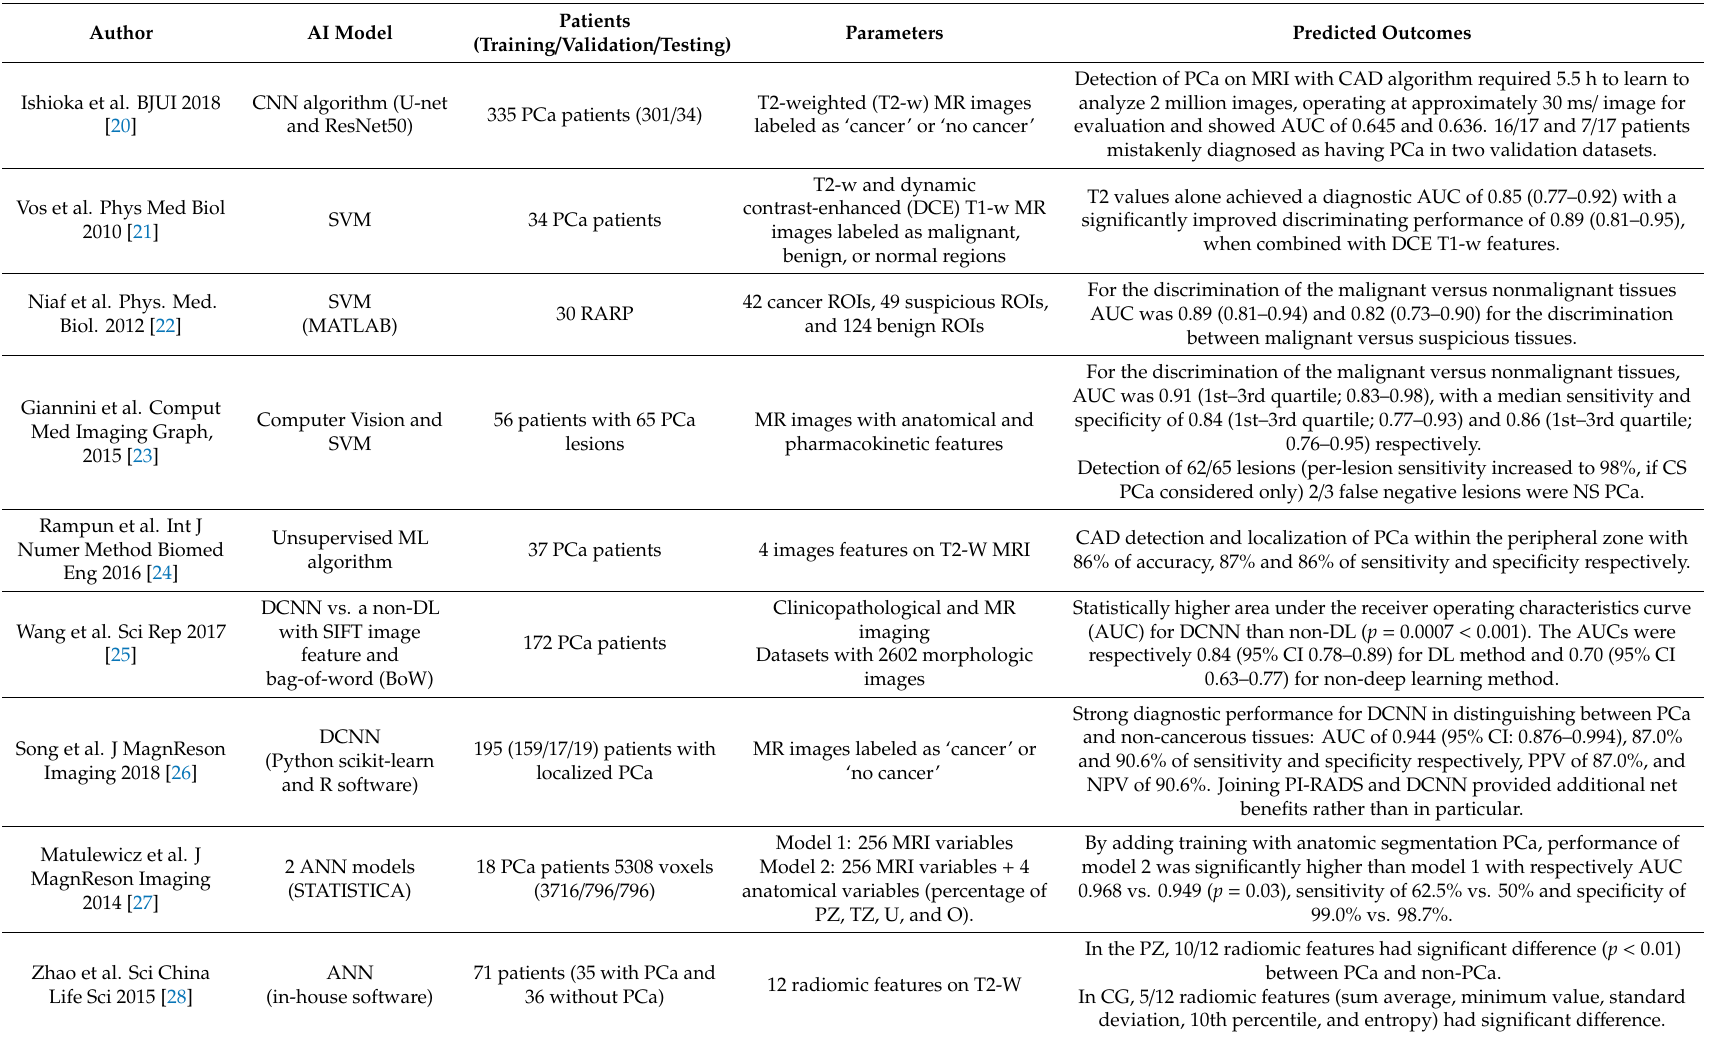
Table 1. Summary of the studies reporting on Artificial Intelligence (AI) in the imaging prostate cancer diagnosis.